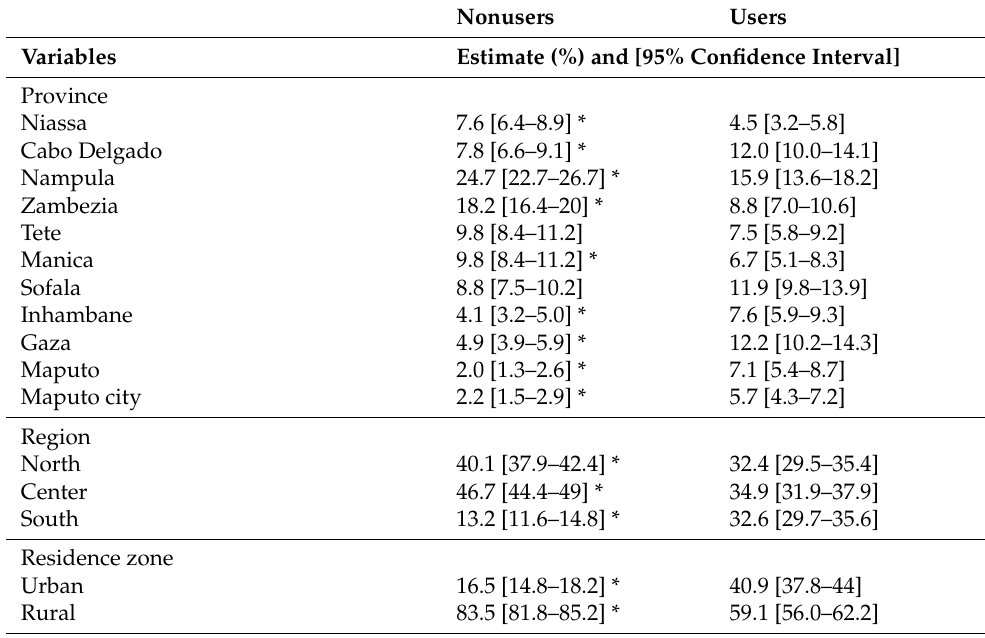
Table A1. Respondents sociodemographic and health characteristics disaggregated by nonusers and users of antenatal consultations and institutional delivery cascade, Mozambique,